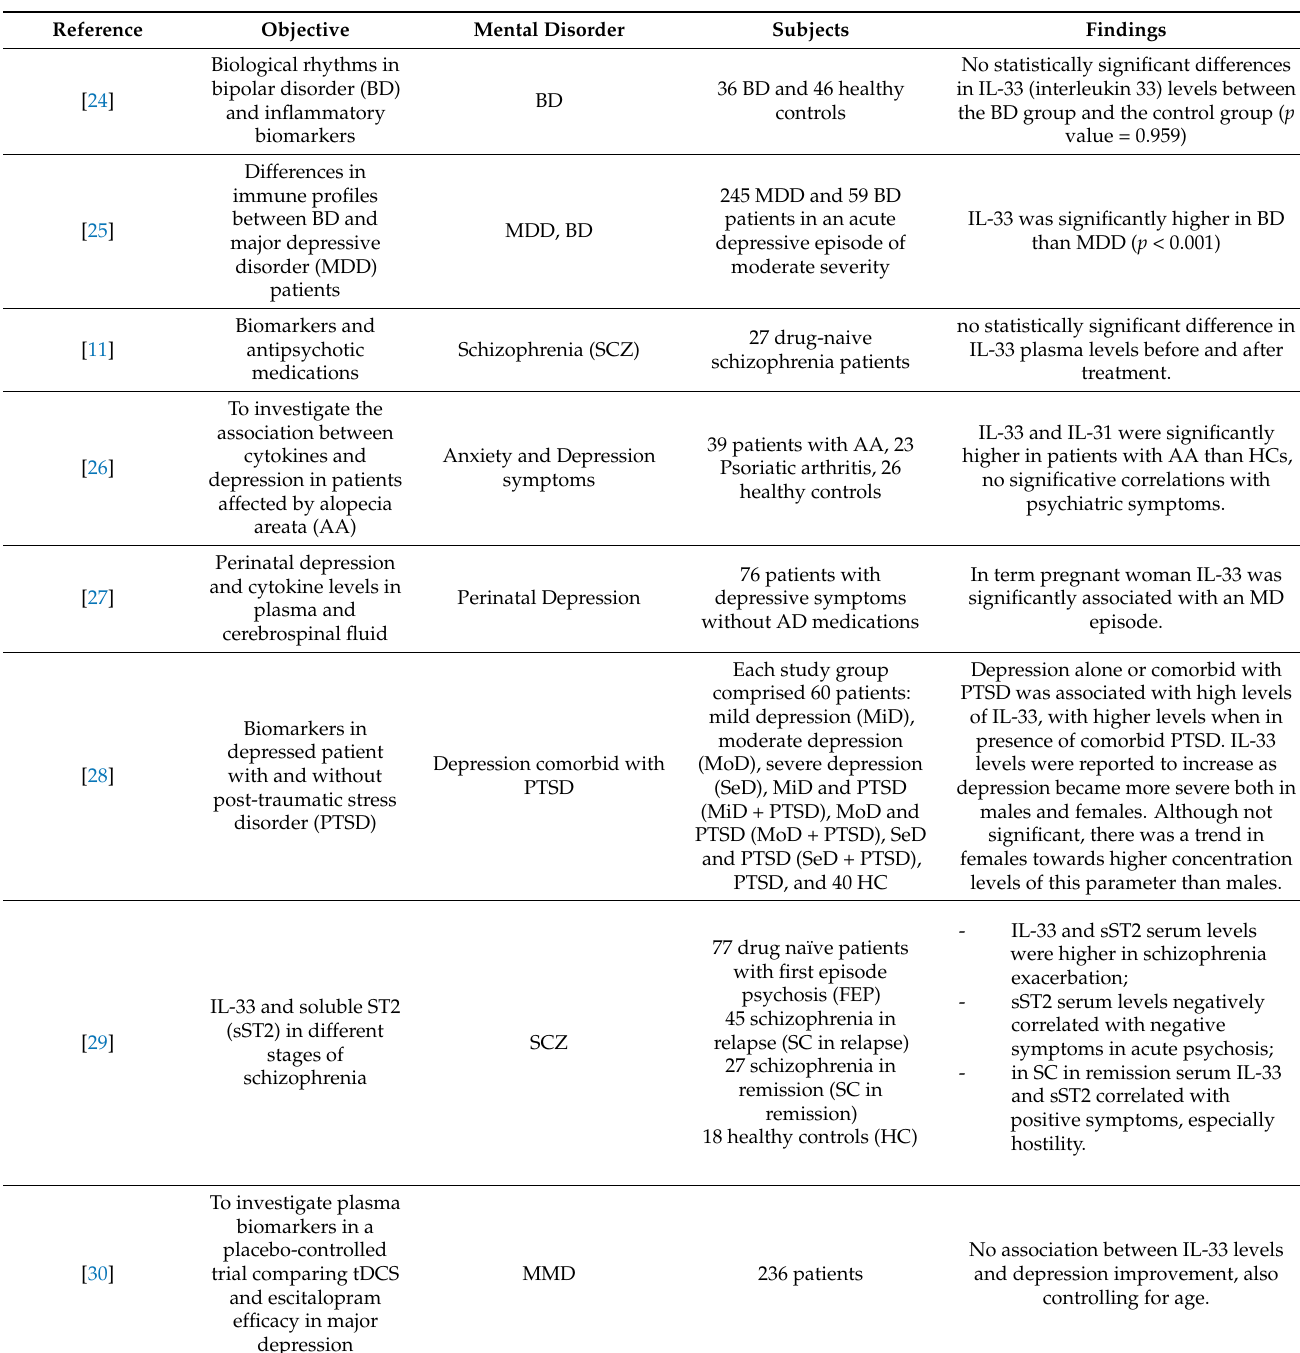
Table 1. The table retrieves the manuscripts evaluating IL-33 in mental